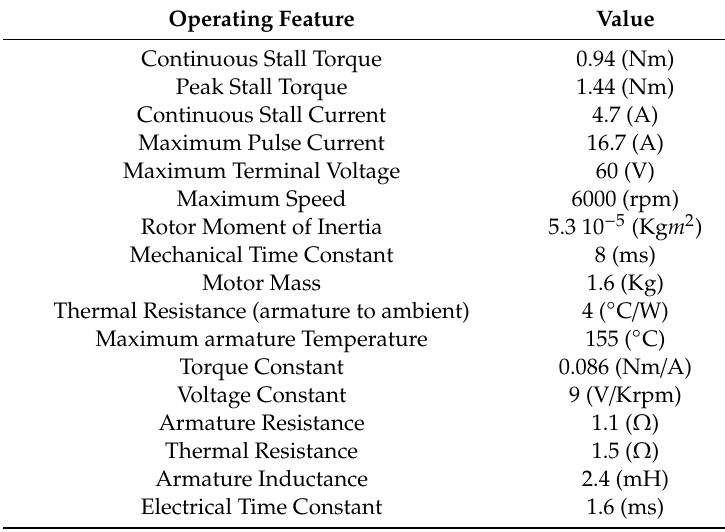
Table 1. Characteristic of the considered brushless DC